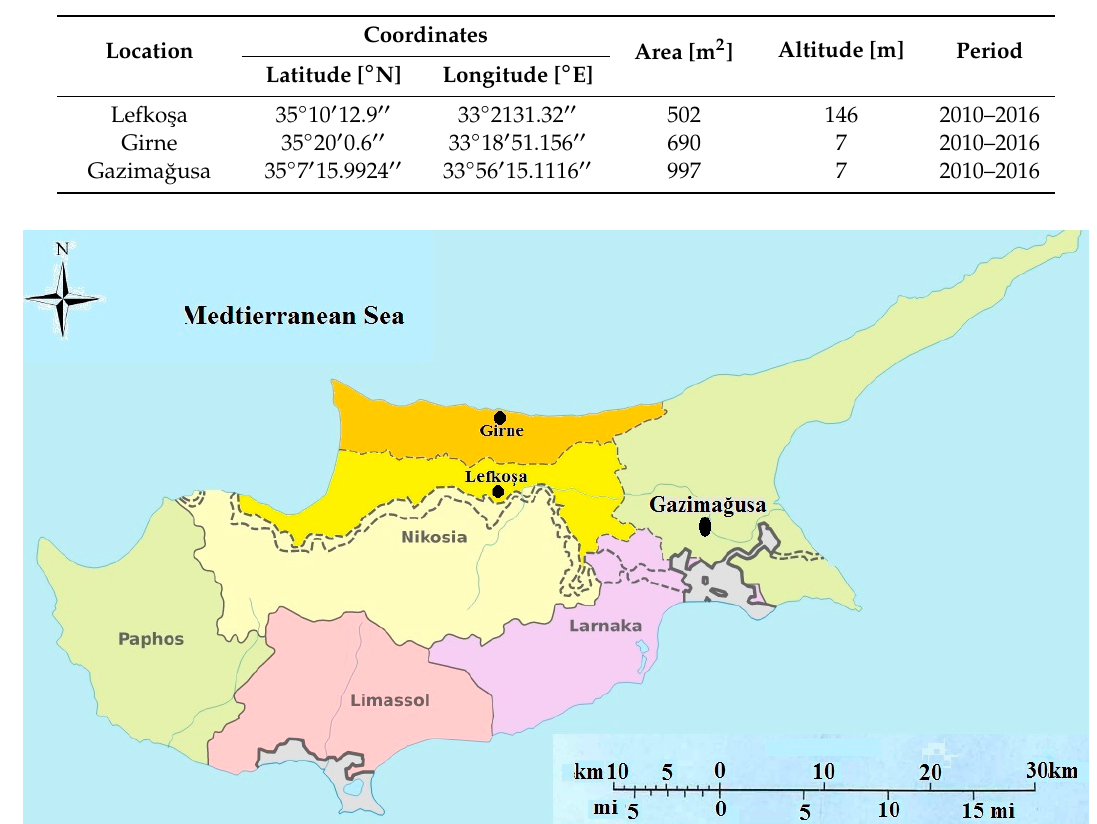
Table 1. Coordinated and period data for the selected regions.